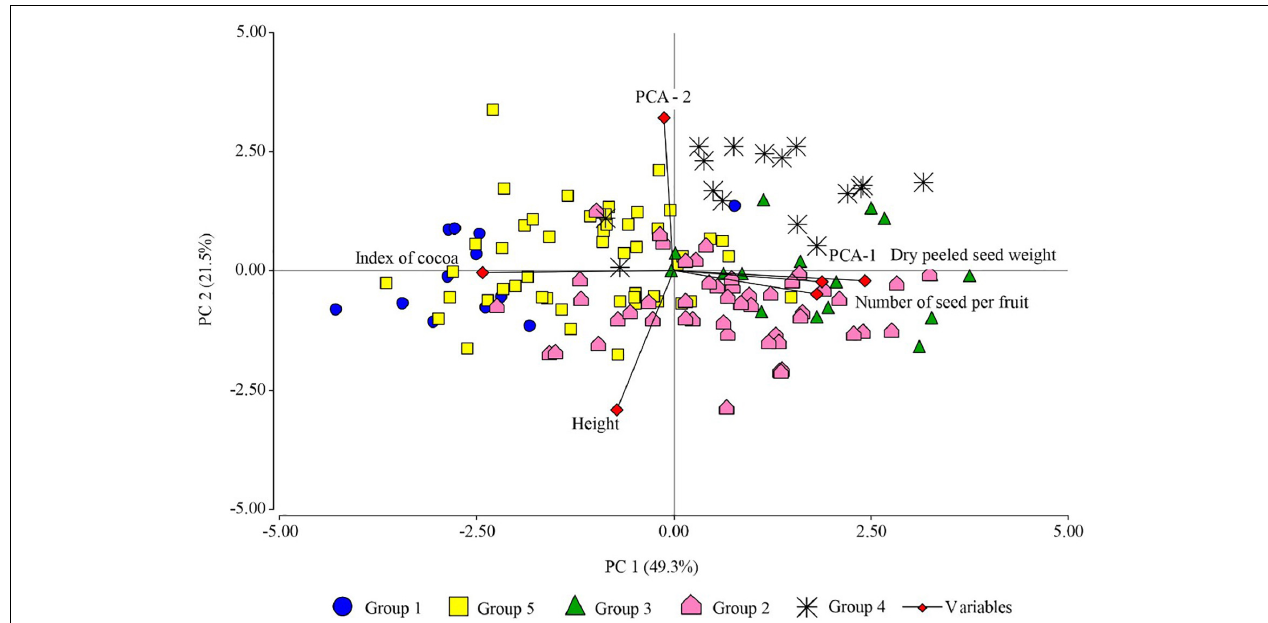
FIGURE 5 | Principal component analysis showing FFNC ecotypes classified into genetic group (GG), based on productivity characteristics (number of seeds per pod, fresh seed weight per ear, dry peeled seed weight, and pod index), altitude sampling, and the two principal coordinates (PCO-1 and PCO-2) of pod and seed morphological descriptors (unripe pod color, pod shape, ridge pair disposition, furrow depth, pod surface rugosity, basal constriction, pod wall thickness, and seed form in the transverse section), sensory characteristics (sweetness, acidity, floral, and fruity), and categorical variables of the productivity criteria (seed length and pod